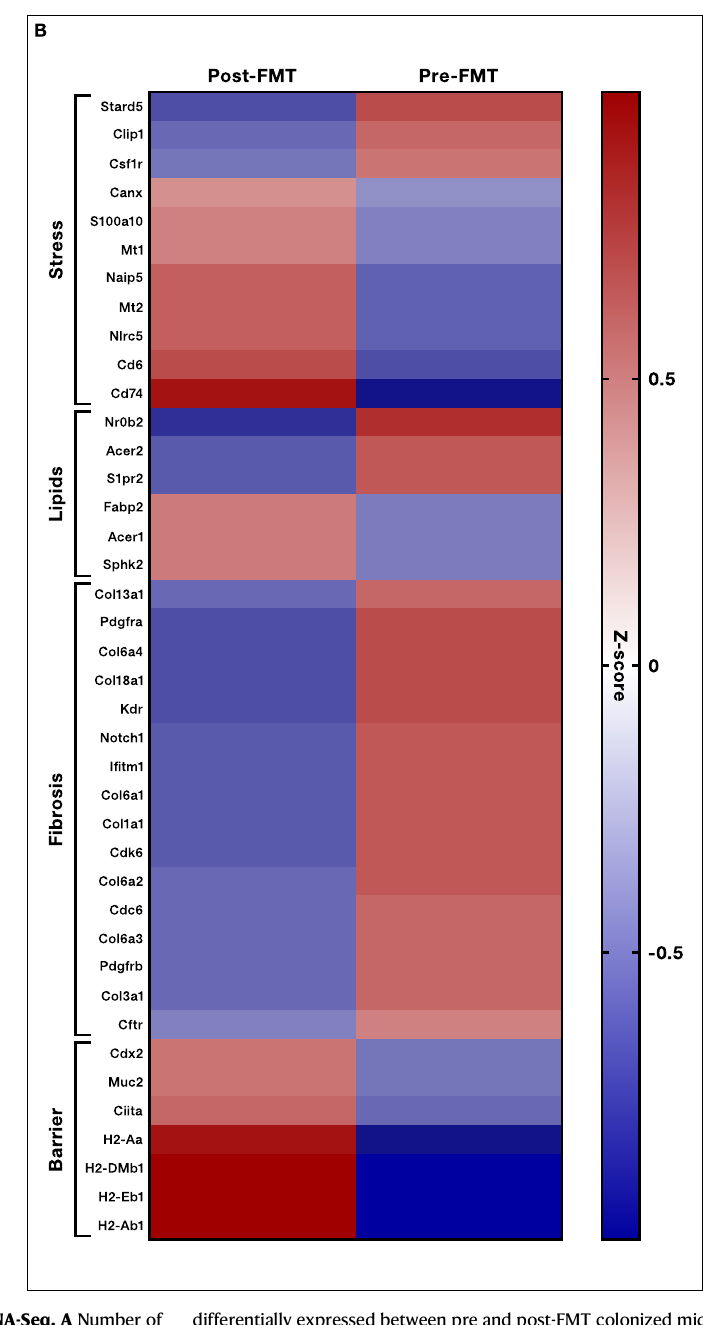
differentially expressed between pre and post-FMT colonized mice exposed to alcohol arranged according to the functional